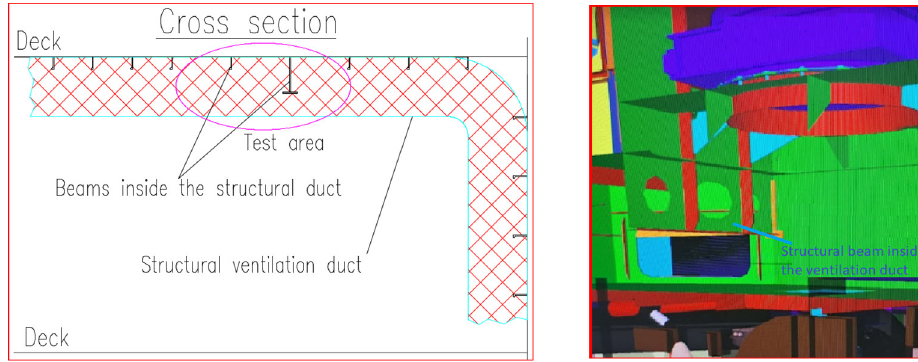
Figure 2. Examples of structural ventilation ducts with ship structural beams inside.